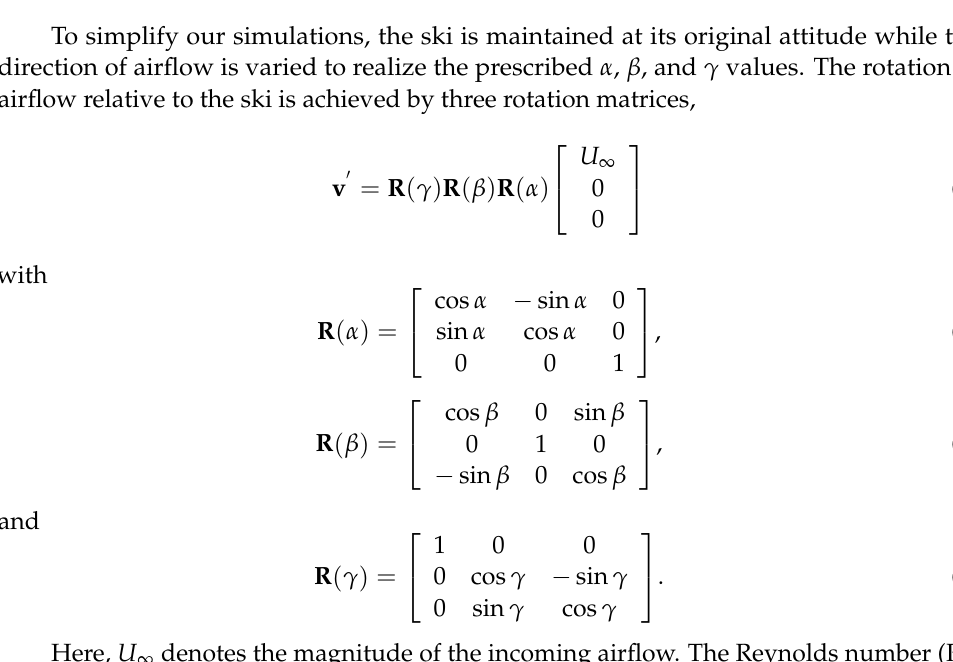
Figure 2. Schematics of a ski jumping ski: ( a ) geometric design and ( b ) definition of attitude angles.